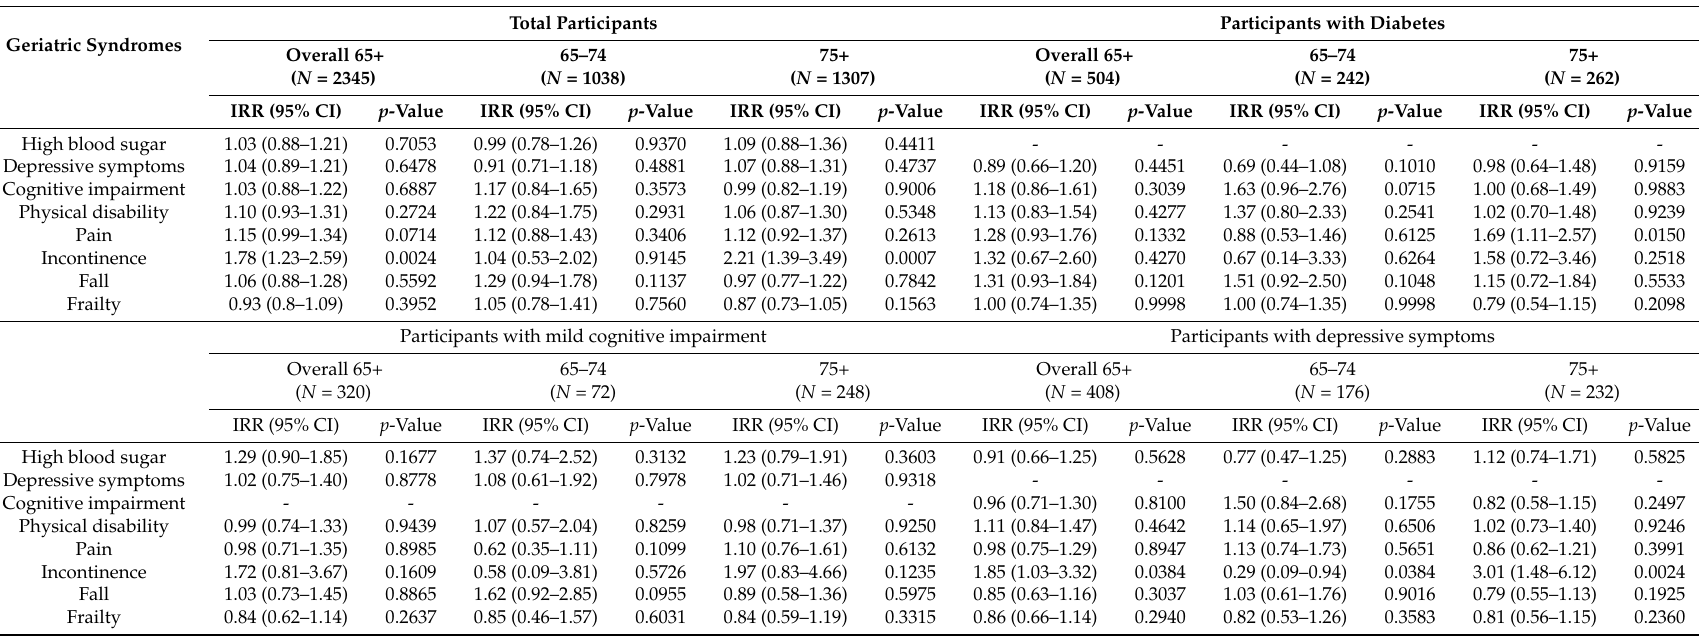
Table 4. Individual effects of geriatric syndrome indicators on number of emergency